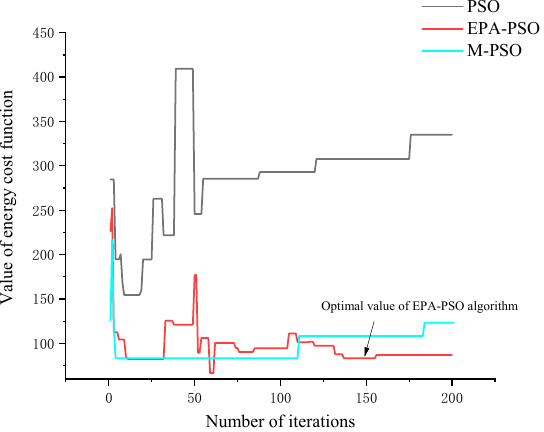
Figure 13. Numerical comparison of energy cost functions after 100 iterations.